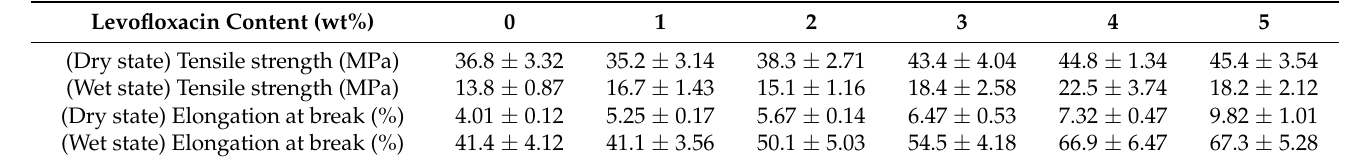
Figure 4. Typical stress-strain curve of gelatin/genipin/levofloxacin membranes in dry state ( a ) and wet state ( b ). Table 1. Tensile strength and elongation at break data for gelatin/genipin/levofloxacin membranes (dry/wet